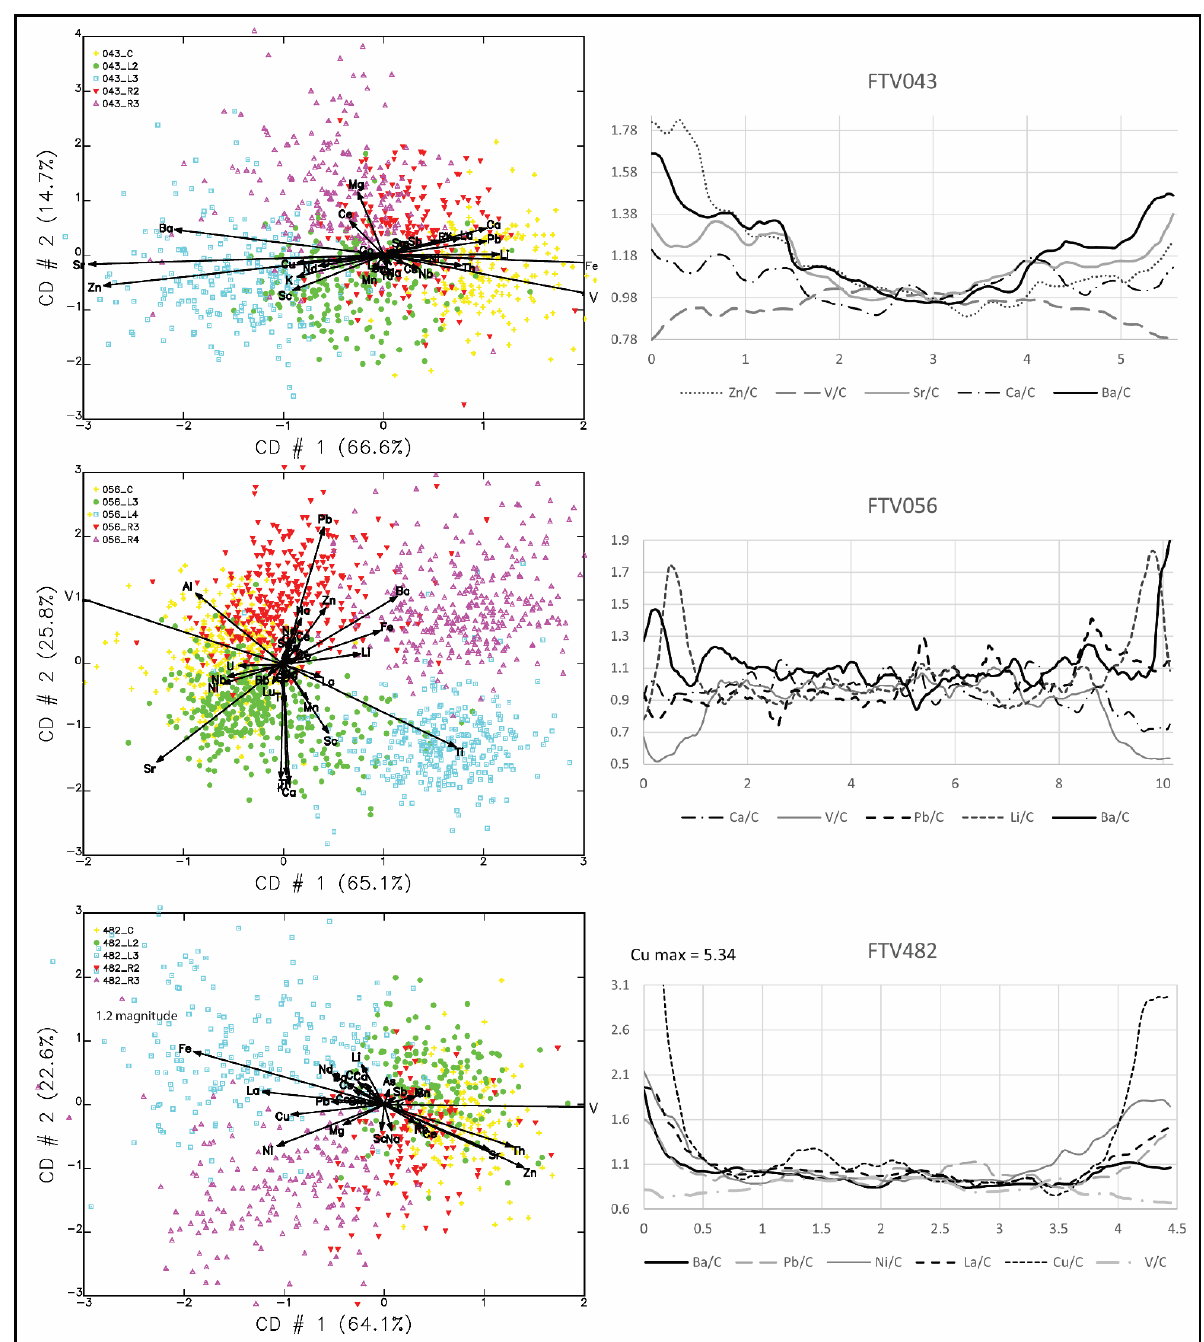
Figure 10. Samples FTV043, FTV056, and FTV482. ( Left ) Canonical discriminant analysis of trimmed data points coded by zone (zones that do not diverge from the core not shown). ( Right ) Profiles of trimmed and smoothed data for elements that show significant zonal patterning. The x-axis is the position in the cross-section of the sherd in millimeters; the y-axis is the concentration of elements (in μg/g) expressed as a ratio to the average core concentration for the same element.